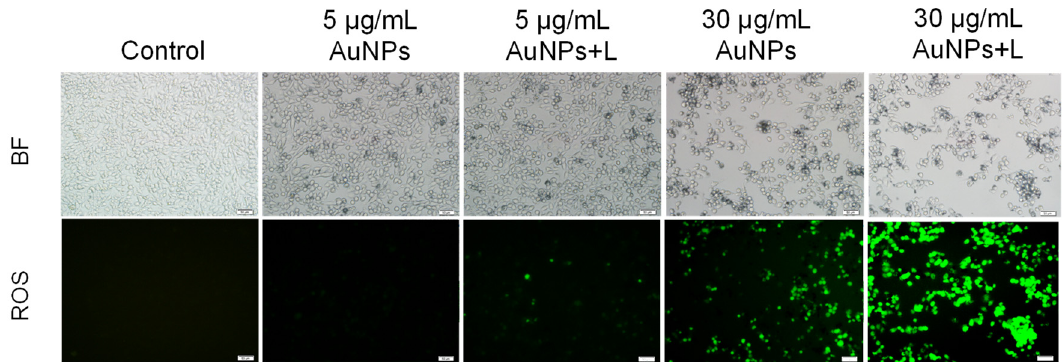
Figure 7. Generated ROS in MDA-MB-231 cells upon exposure to HA-capped AuNPs (with/without NIR lighting) at different Au concentrations, according to a DCFH-DA staining assay. Scale bar represents 50 µ m.